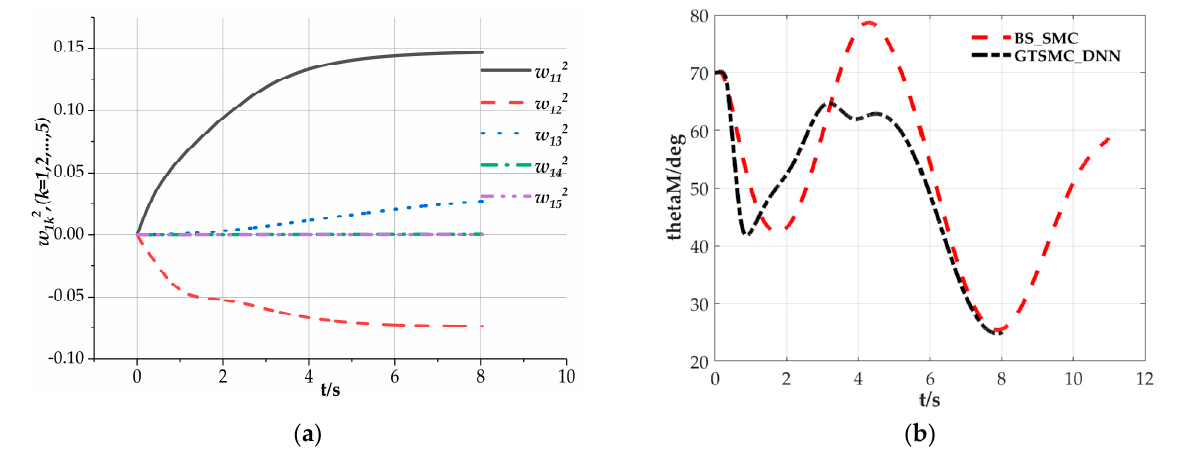
θ angle. Figure 11. ( a ) The adaptive weight parameters of DNN; ( b ) System states of θ m m angle.